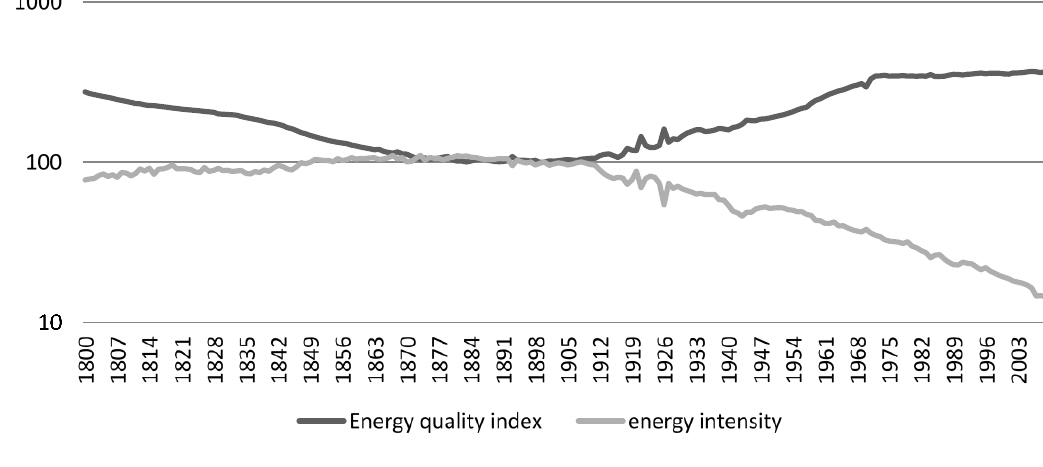
Figure 9. Development of energy quality and energy intensity in Britain 1800–2009 (1900 = 100).